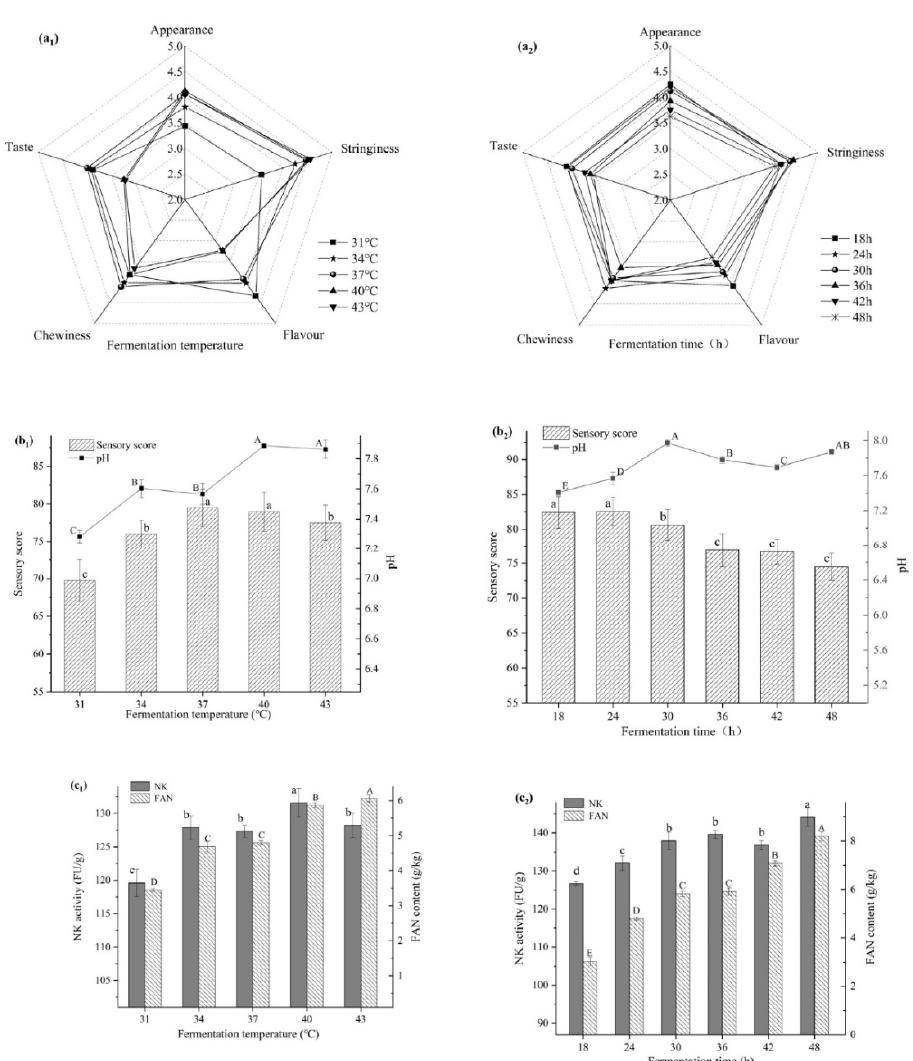
Figure 3. Effects of fermentation temperature ( a 1 – c 1 ) and fermentation time ( a 2 – c 2 ) on natto fermen- tation. Different letters above each bar means significant differences.